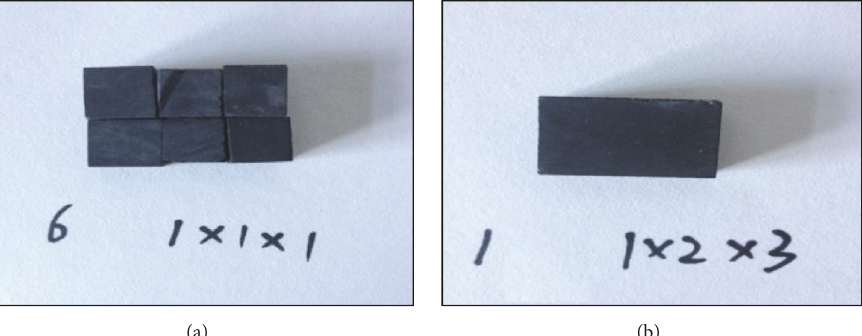
Figure 2: Shale samples of Case 2. (a) Six small samples (1cm × 1cm × 1cm); (b) one large sample (1cm × 2 cm × 3 cm) of the same volume with six small samples in